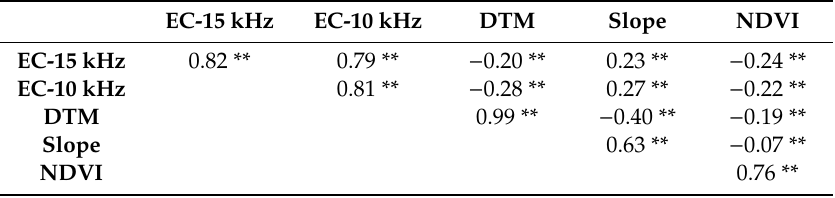
Table 4. Moran Index among the variables used to delineate SSMZ, estimated (using GeoDa software, by Luc Anselin) considering the grid nodes with valid EMI measurements (area ‘a’).